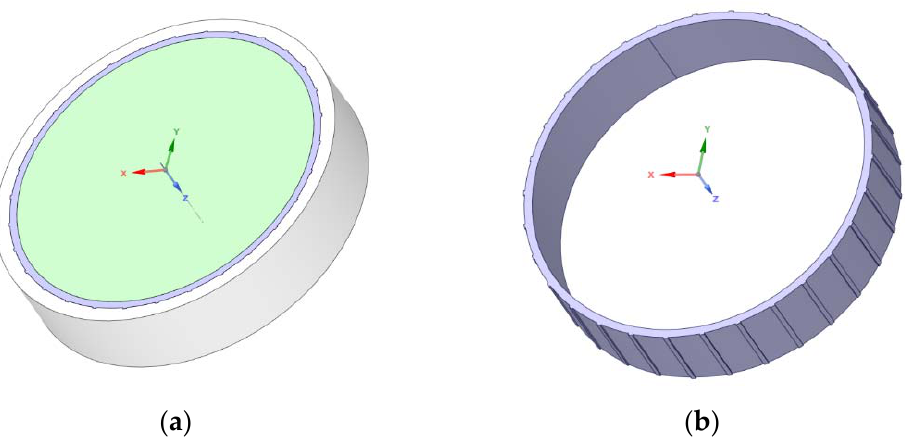
Figure 1. Schematic diagram of the seal structure. ( a ) Overall view of sealing structure; ( b ) annular flow field. flow